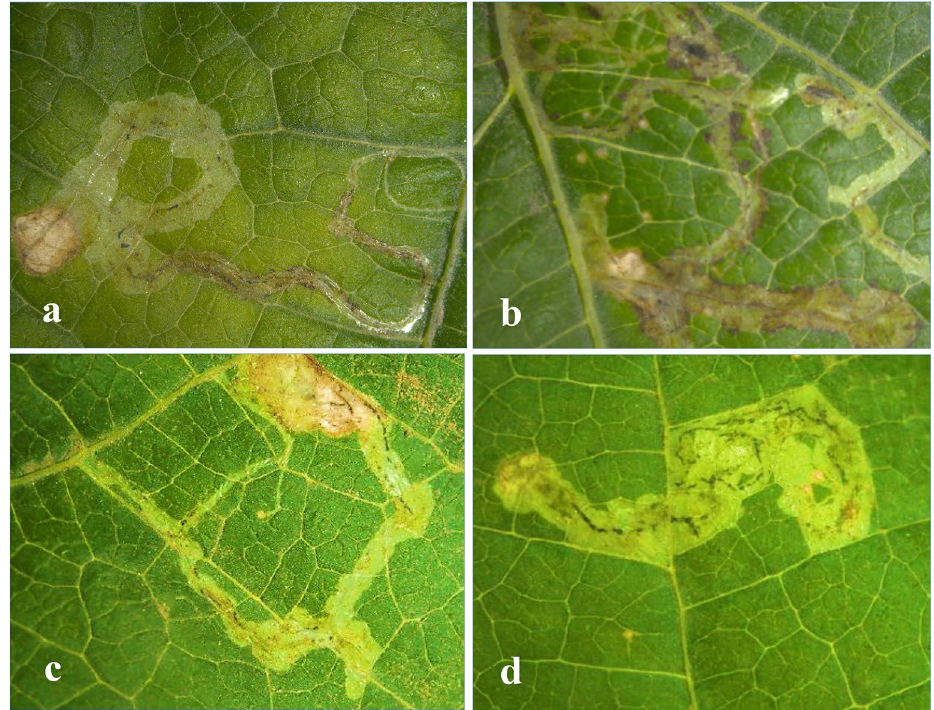
Figure 2. Damage caused by the larvae infestation of the L. trifolii in P. vulgaris cvs showing the effects of treatment with BSTC on resistance. Symptoms of L. trifolii on the leaves of P. vulgaris ( a ) AlHama control, ( b ) AlHama treated with BSTC showing dead larva, ( c ) Moraleda control and ( d ) Moraleda treated with BSTC with dead larva.